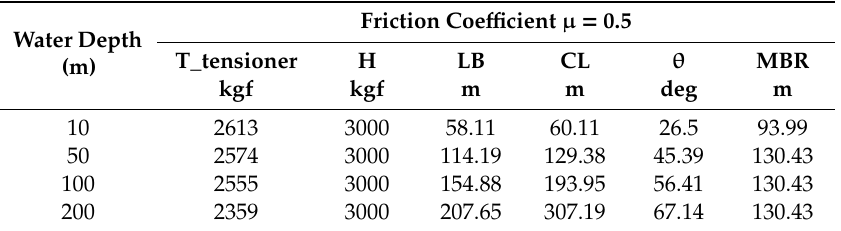
Table 5. Cable critical responses assuming friction coe ffi cient µ = 0.50.